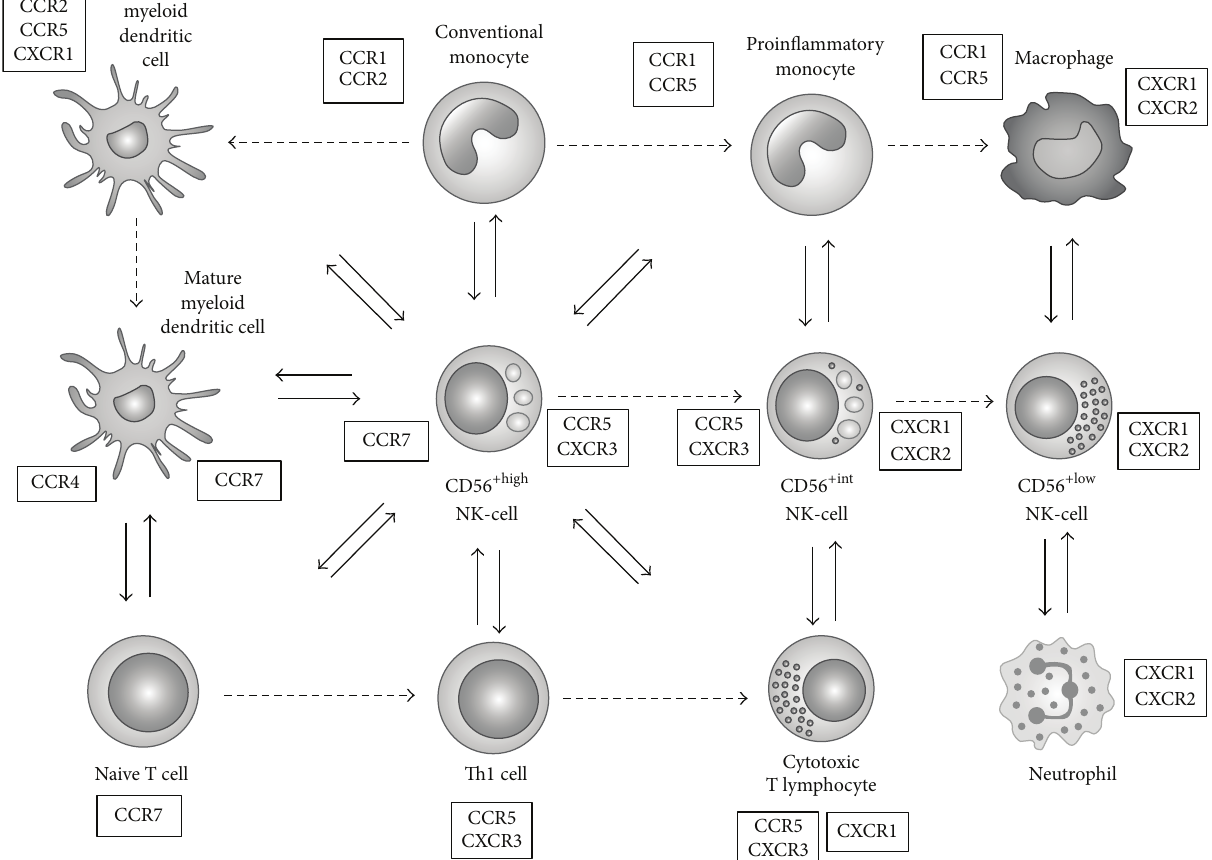
Figure 4: Diagram illustrating the complex relationship established between NK-cells and the other cells of the innate-dendritic cells (DC), monocytes, macrophages, neutrophils, and adaptive (T cells) immune system, whose homing to lymphoid organs and recruitment to inflamedtissuesaremediatedbytheinteractionofhomeostaticchemokinesconstitutivelyexpressedonlocallyresidentcellsandinflammatory chemokines,withthecorrespondentchemokinereceptors.CCR7expressiononCD 56 + high NK-cells,matureDC,andna¨ıveTcellsallowsthese cells to migrate into the lymph nodes, in response to CCL19 (ELC) and CCL21 (SLC) produced locally. CXCR3/CCR5 expression on CD 56 + high NK-cells permits these cells to migrate into inflamed tissues, together with CCR5 + proinflammatory monocytes, CCR5/CXCR3 + Th1 cells, and CCR5/CXCR3 + cytotoxic T lymphocytes (CTL). CXCR1/CXCR2 expression on CD 56 + low NK-cells, neutrophils, and CTL permits these cells to migrate into inflamed tissues in response to CXCL8 (IL-8), where they interact together and with activated macrophages. CD 56 + int NK-cells are transitional NK-cells, whose properties are intermediate between those of CD 56 + high and CD 56 + low NK-cells. Dashed arrows indicate the routes of differentiation. Full arrows indicate the cross-talk between cells mediated by cytokines and chemokines. CCR7 ligands: CCL-19 (ELC) and CCL21 (SLC); CCR5 ligands: CCL3 (MIP-1 𝛼 ), CCL4 (MIP-1 𝛽 ), CCL5 (RANTES), and CCL8 (MCP-2); CXCR3 ligands: CXCL9 (MIG), CXCL10 (IP-10), and CXCL11 (I-TAC); CXCL1 ligands: CXCL-8 (IL-8); CXCL2 ligands: CXCL-8 (IL-8) and other ELR motif containing CXCL chemokine; CXCR4 ligand: CXCL12 (SDF-1); CCR1 ligands: CCL3 (MIP-1 𝛼 ), CCL5 (RANTES), MCP-2, and MCP-3; CCR2 ligands: CCL2 (MCP-1), CCL8 (MCP-2), CCL7 (MCP-3), and CCL13